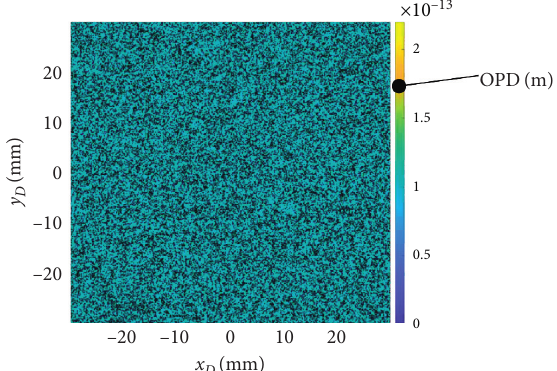
L 1 (a) and z L 2 (b).